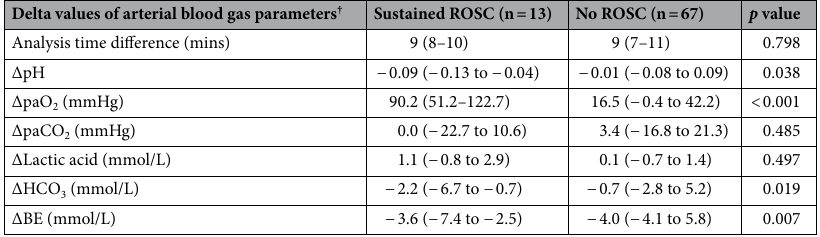
Table 2. Delta values of parameters between the initial and second arterial blood gas analysis. BE base excess, HCO